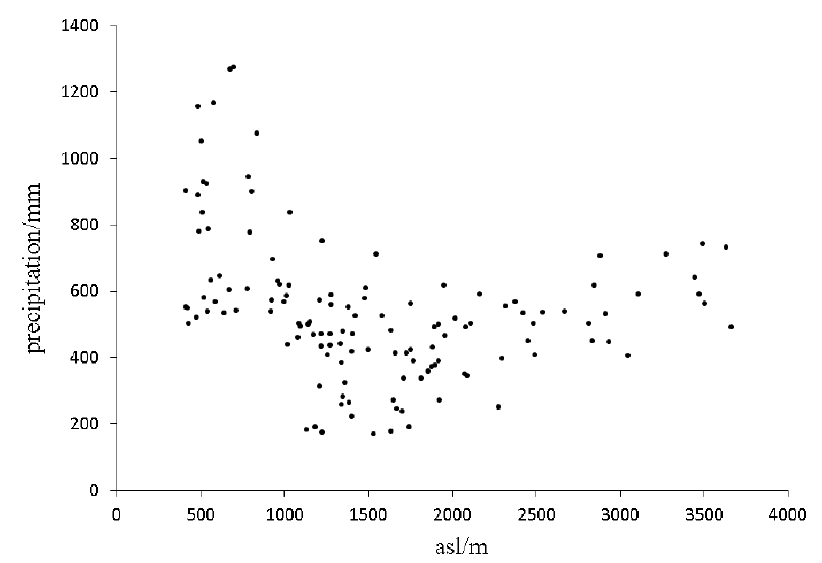
Figure 2. Precipitation distribution at different elevations.